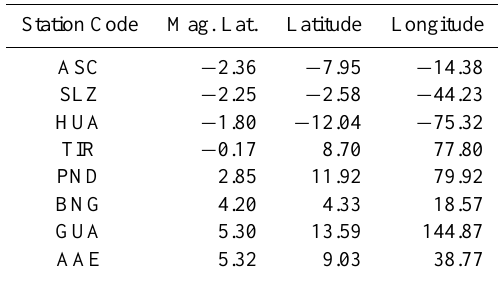
Table 1. Geographic coordinates and magnetic latitude of the mag- netometer stations. Station Code Mag. Lat.